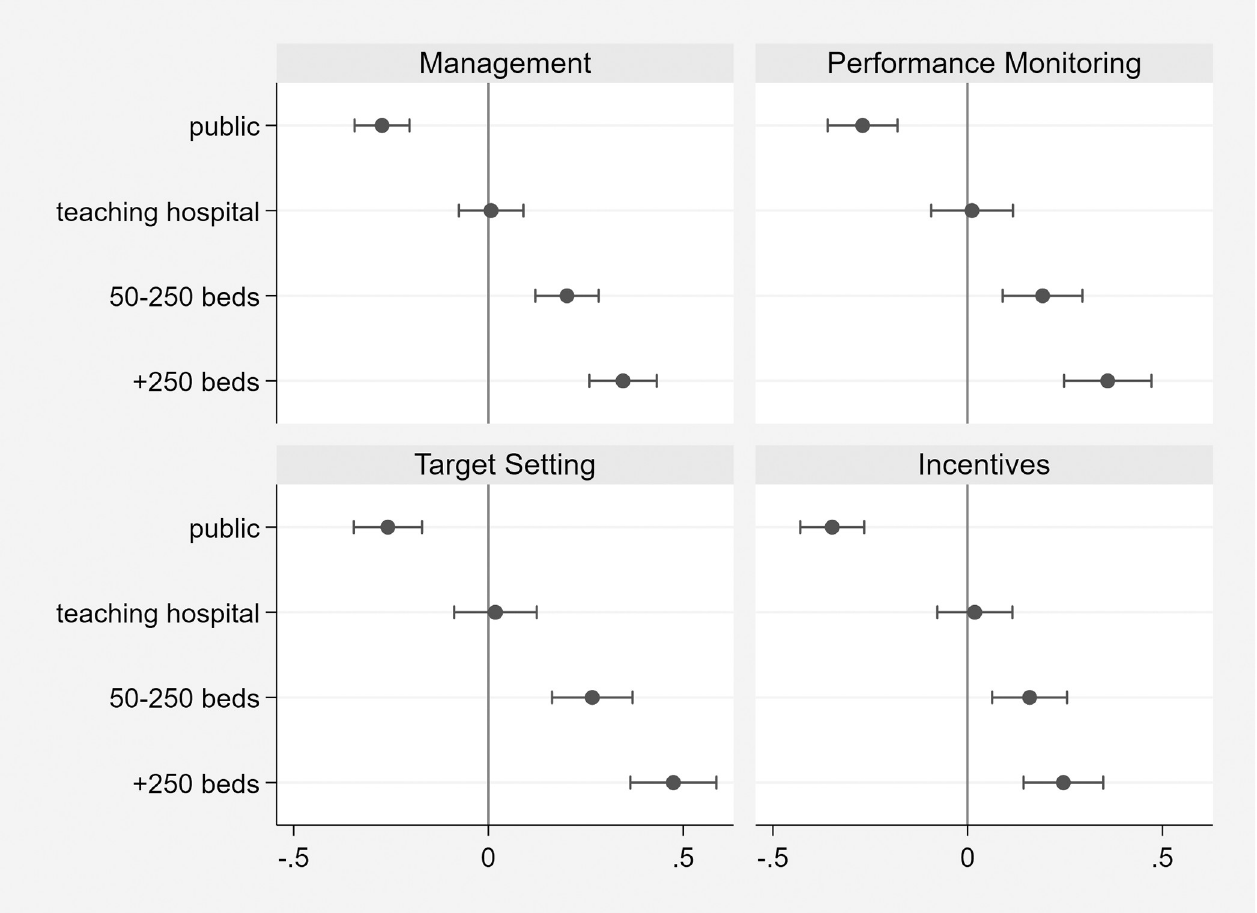
Fig 3. Differences in management dimensions. Source: World Management Survey (Hospitals